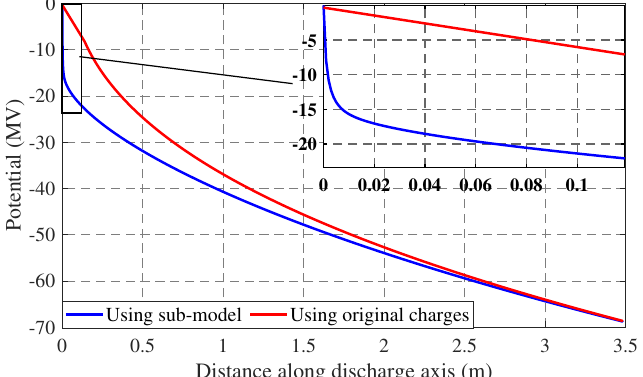
Figure 7. Comparison of computed potentials along